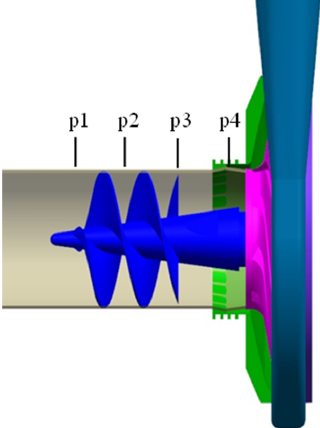
Figure 11. Monitoring points on the inducer wall.